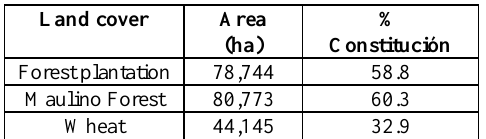
Table 4 . Areas of Maulino forest (potential original), plantation (actual) and wheat (1871-75) in the study area.